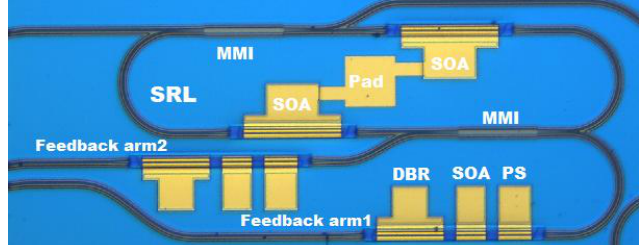
Figure 1. Image of the semiconductor ring laser with filtered feedback, in which the different laser and feedback components are indicated.